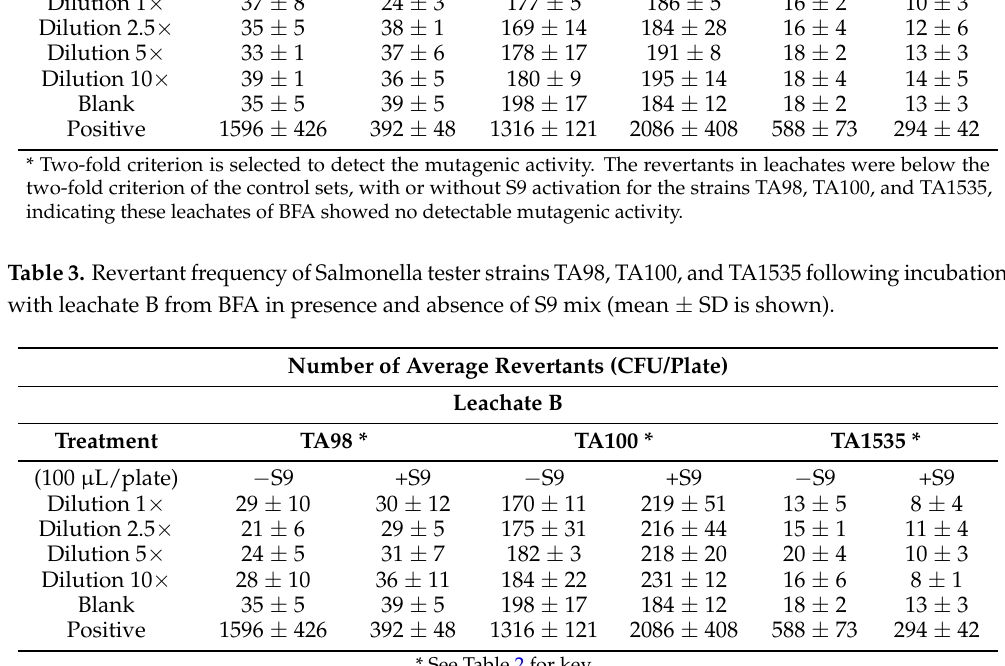
Table 4. Revertant frequency of Salmonella tester strains TA98, TA100, and TA1535 following incubation with leachate C from BFA in presence and absence of S9 mix (mean ± SD is